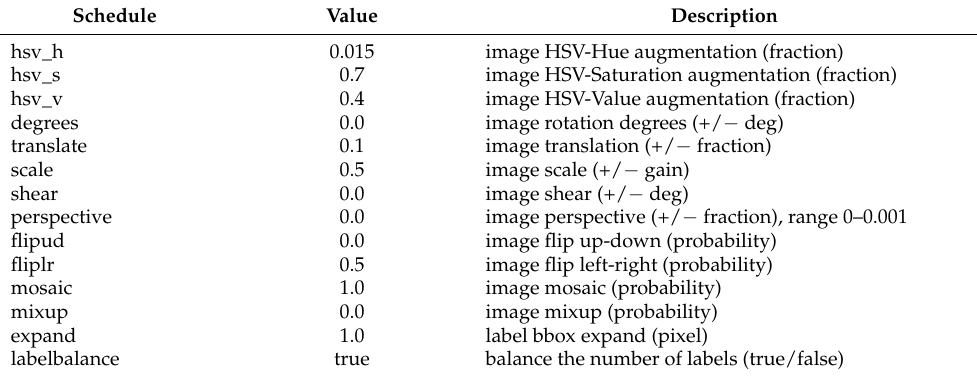
Table 1. Summary of the training strategies